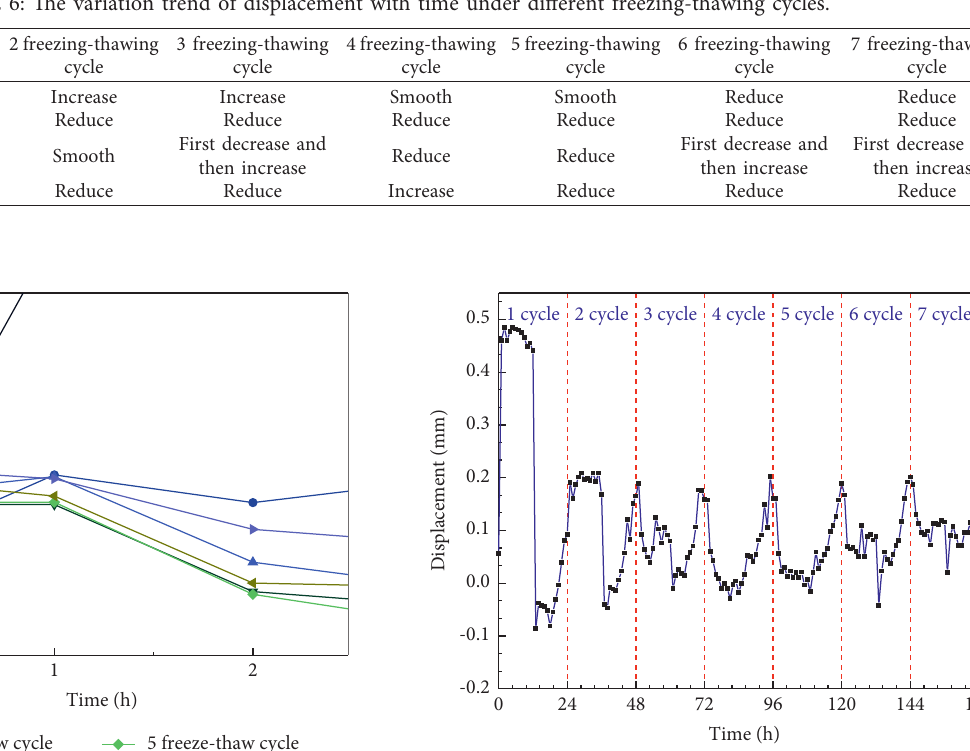
Figure 10: Salt-frost heaving process and duration curve of chlorite saline